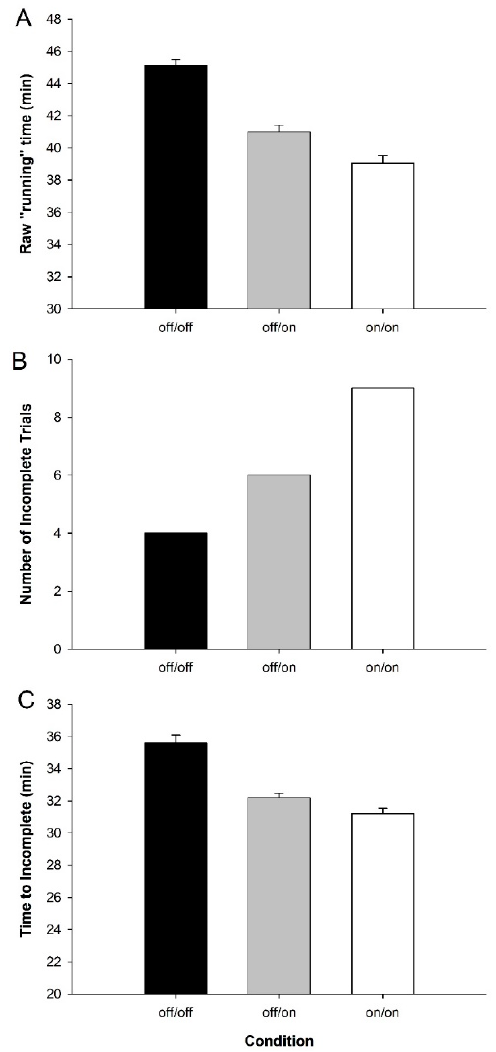
Figure 2. Raw performance data for all trials ( n = 13): ( A ) average run time, including incomplete trials across condition; ( B ) number of incomplete trials across condition; and ( C ) average time to incompletion across conditions. Data are means ± Standard Error.